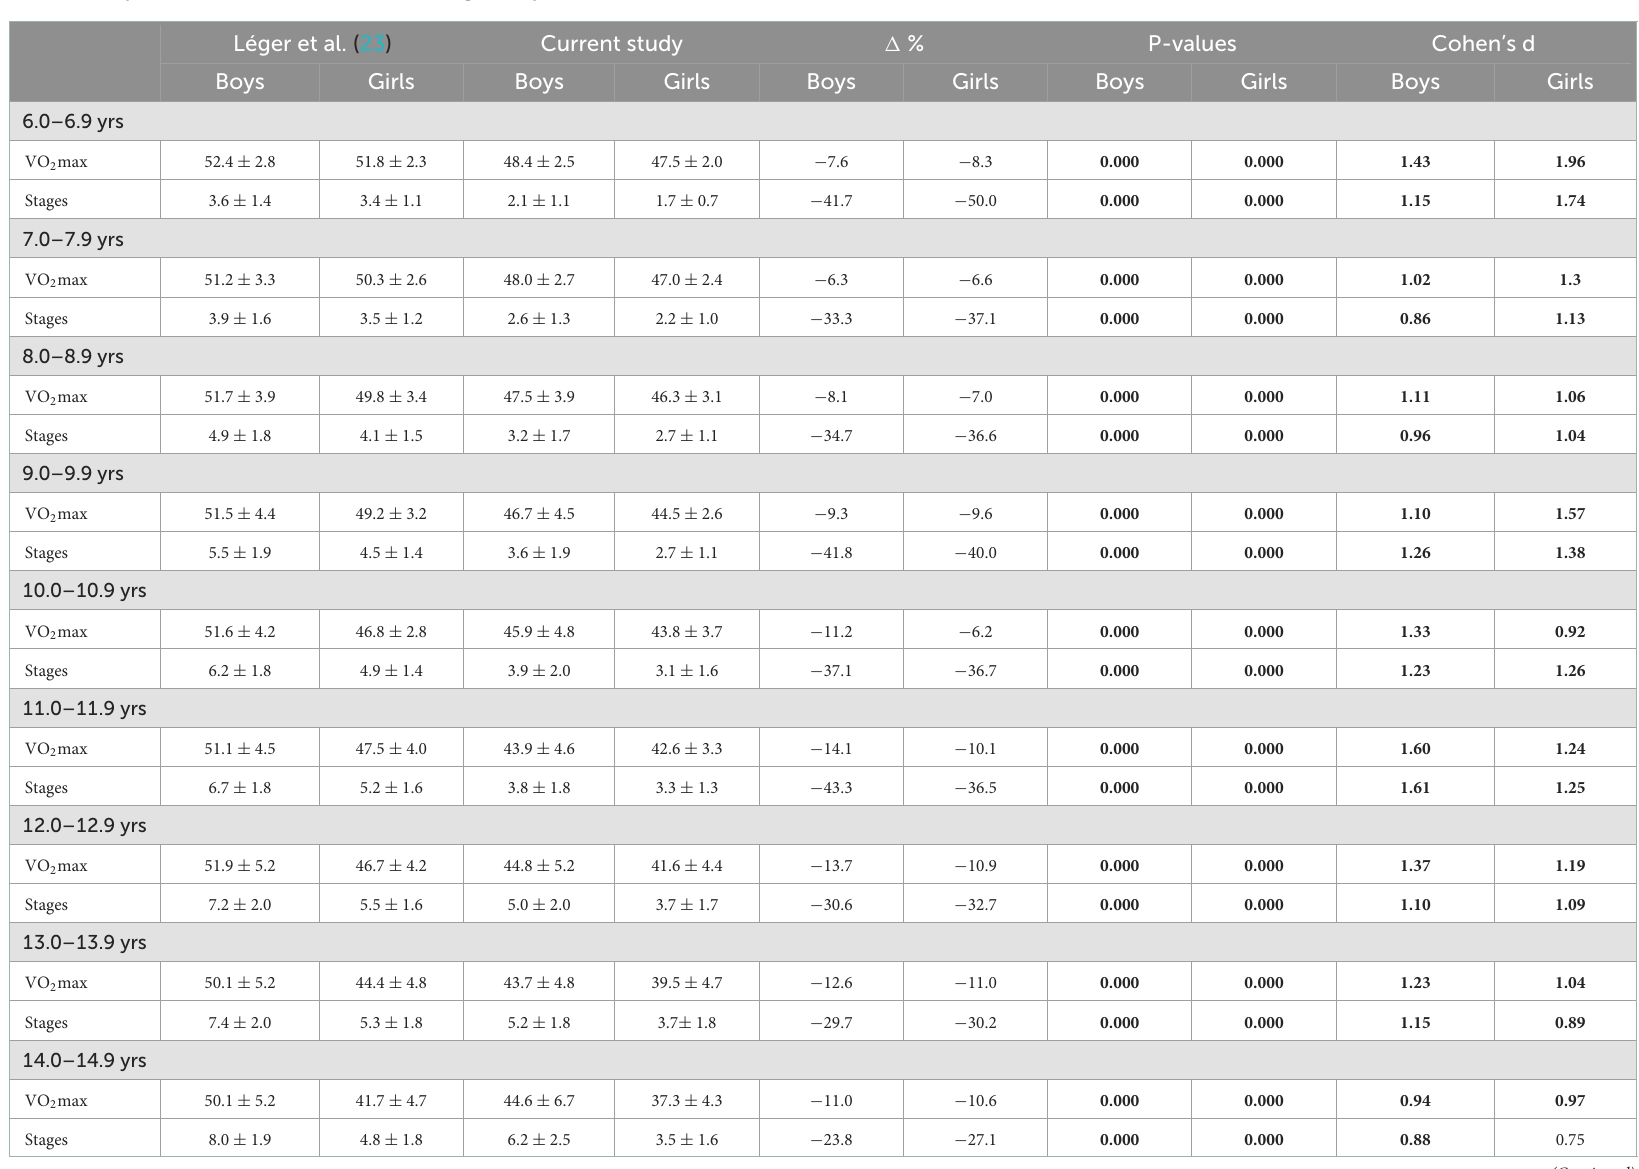
TABLE 5 Comparison of VO 2 max and the number of stages completed in children and adolescents between 1982 and 2017. Léger et al.